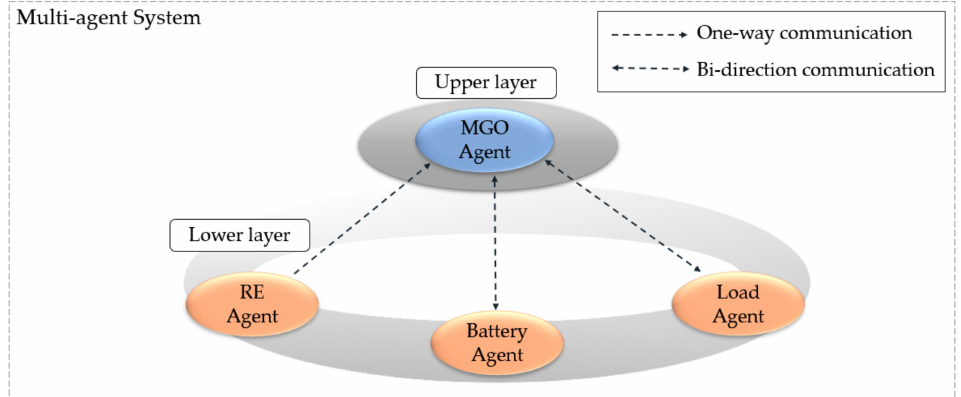
Figure 2. Proposed two-layer multi-agent system (MAS)